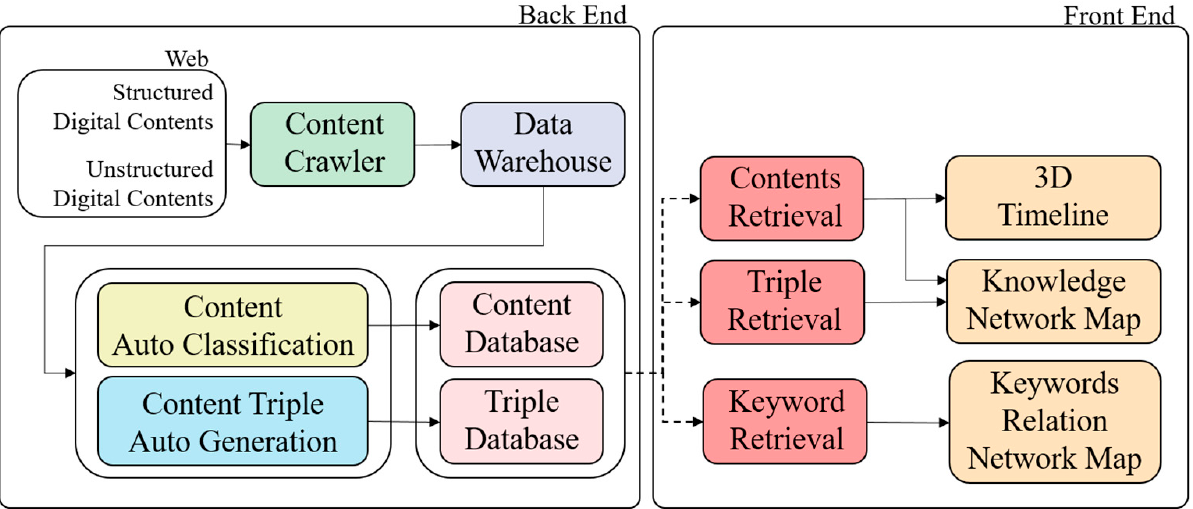
Figure 1. Structure of Intelligent Information System.